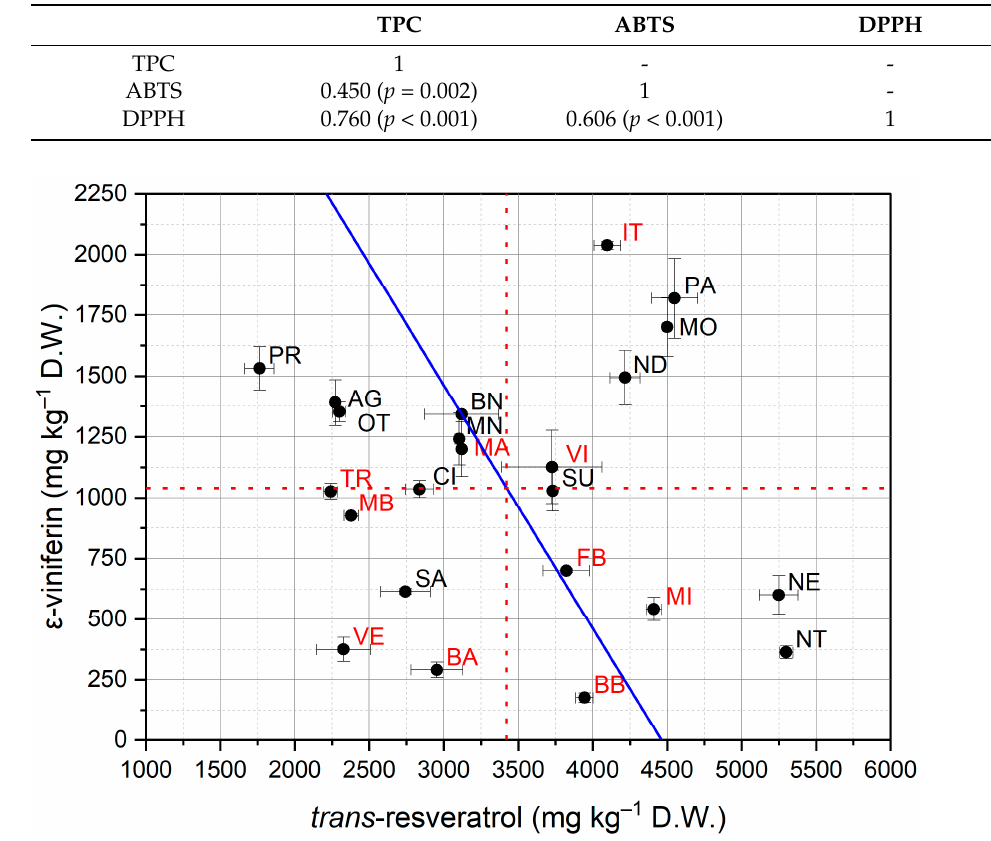
Figure 1. The stilbene contents in vine shoots from 23 different Italian varieties. Red dotted lines— the mean contents of trans -resveratrol (Rsv) and ε -viniferin (Vf); blue solid line—the mean content of trans -resveratrol + ε -viniferin. Black labels indicate black grape varieties; red labels indicate white grape varieties. For sample codes, see Table 1.